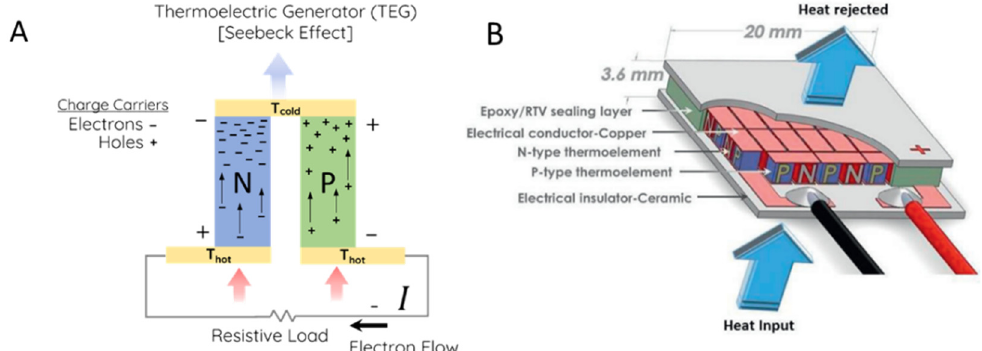
Figure 1. Representation of a thermoelectric generator: ( A ) Flow of charge carriers in a pair of n- and p-type leg pair; ( B ) schematic of thermoelectric generator module [12,13].